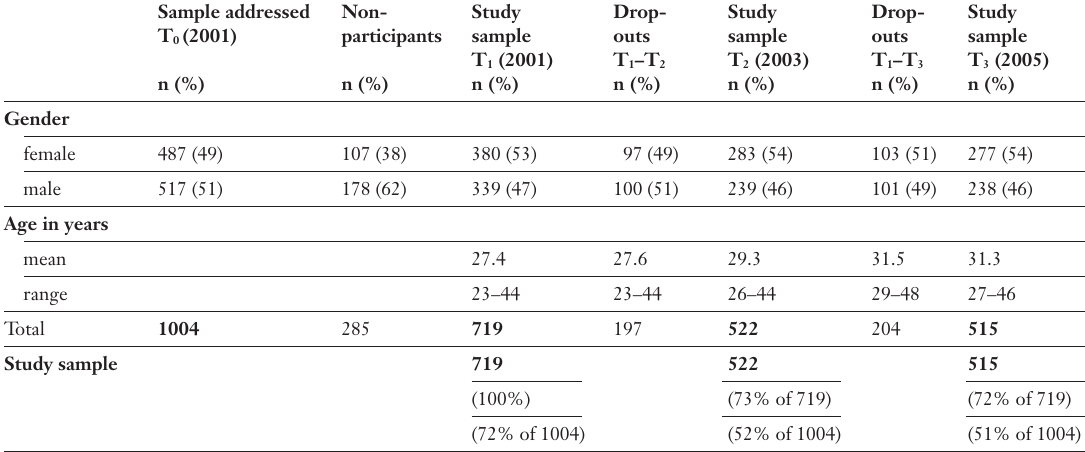
Sample development of the study